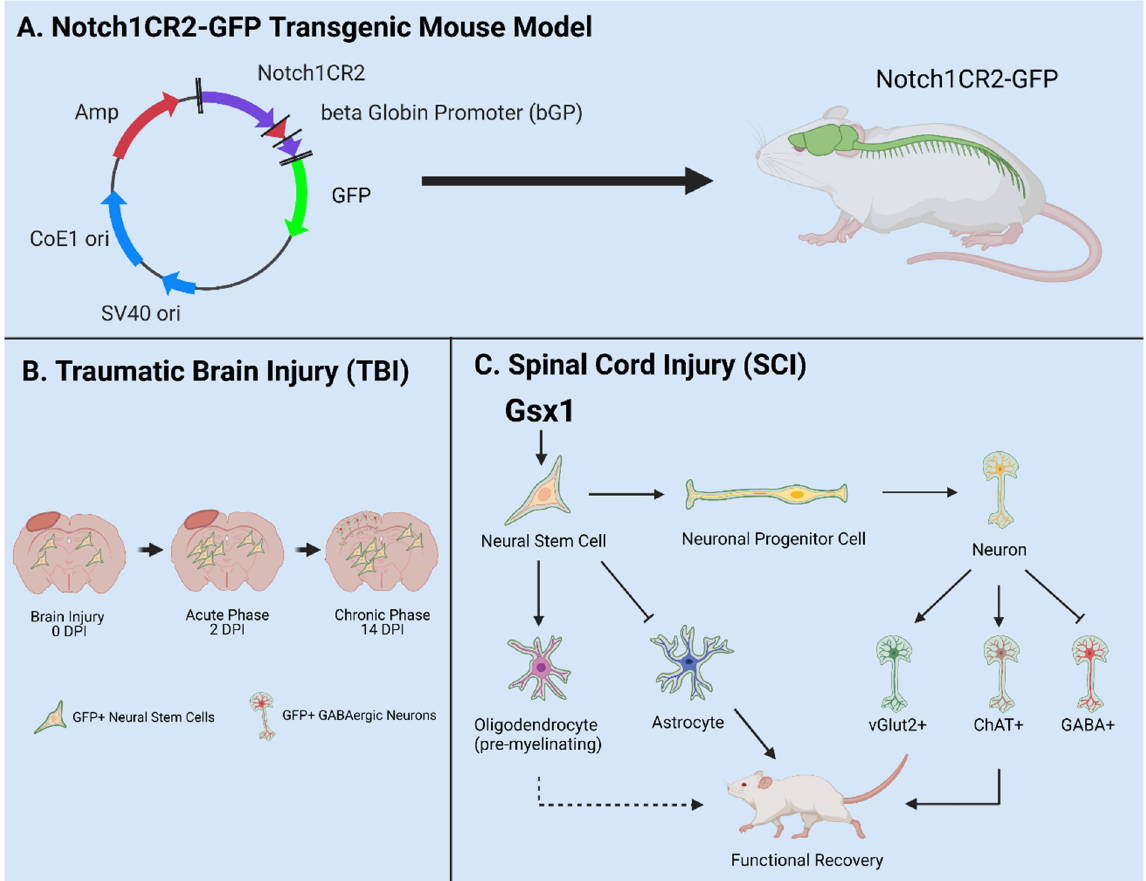
Figure 3. Utilities of the Notch1CR2-GFP transgenic mouse line in SCI and TBI models. ( A ) Notch1CR2-GFP transgenic mouse model labels NSPCs in the CNS. ( B ) Adult NSPCs in the brain proliferate in the acute phase of TBI and differentiate into neurons in the chronic phase of TBI. ( C ) In the injured spinal cord, Gsx1 expression promotes adult NSPC proliferation and preferential differentiation into excitatory interneurons and inhibits astrocytes and glial scar formation after injury. Adapted from Tzatzalos, et al., 2012 [81] ( A ), Anderson et al., 2020 [80] ( B ) and Patel et al., 2021 [79] ( C ).